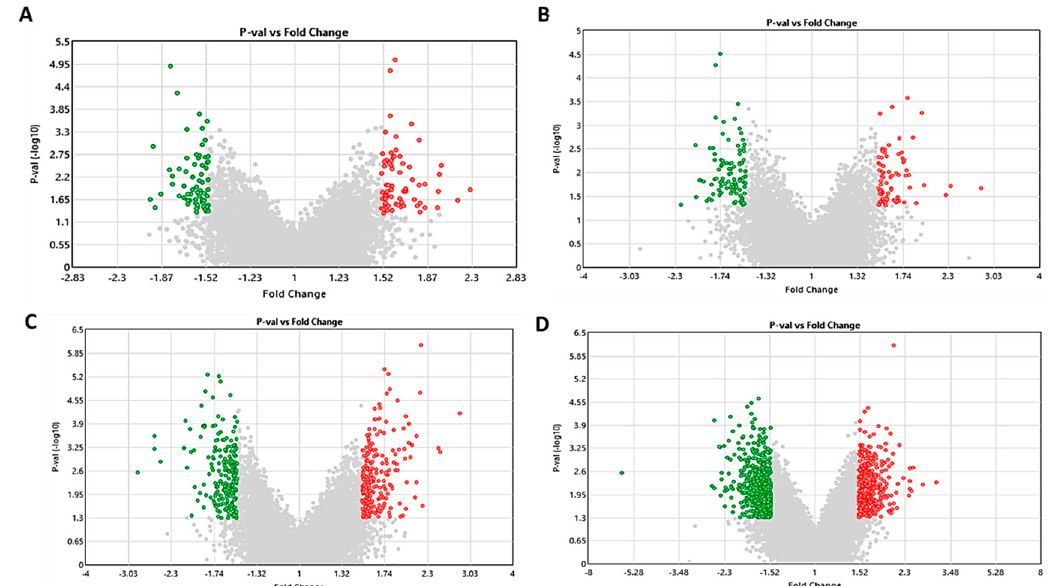
Figure 3. Volcano plots [fold change vs. p -value ( − log 10 )] displaying differentially expressed genes (DEGs) in pre- and differentiated adipocytes treated with 100 nM S1P compared to vehicle control. Genes with fold change ≤ − 1.5 (green) and ≥ 1.5 (red) and p < 0.05 are highlighted in SGBS preadipocyte ( A ), 3T3-L1 preadipocyte ( B ), differentiated SGBS adipocyte ( C ) and differentiated 3T3-L1 adipocyte ( D